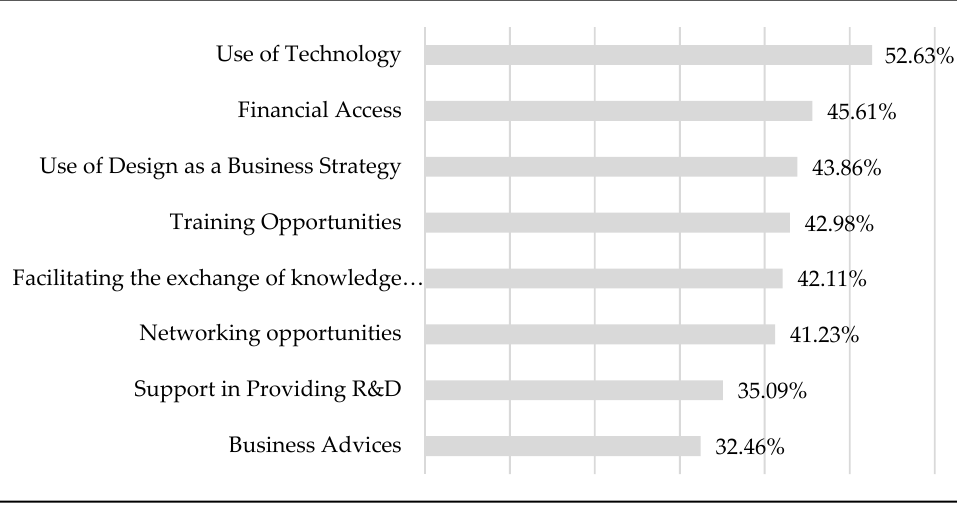
Figure 6. Factors supporting CCIs. Source: Authors elaboration on data collected and shown in TRACES D3.1 deliverable.